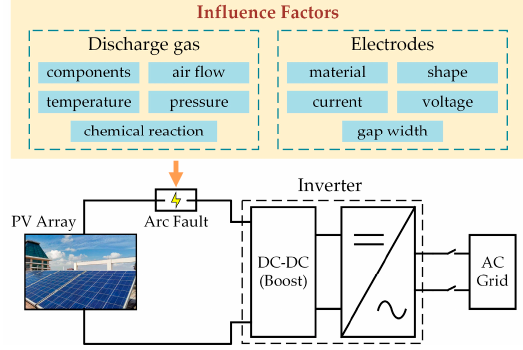
Figure 2. The topology of experimental circuit and influence factors of arcing.